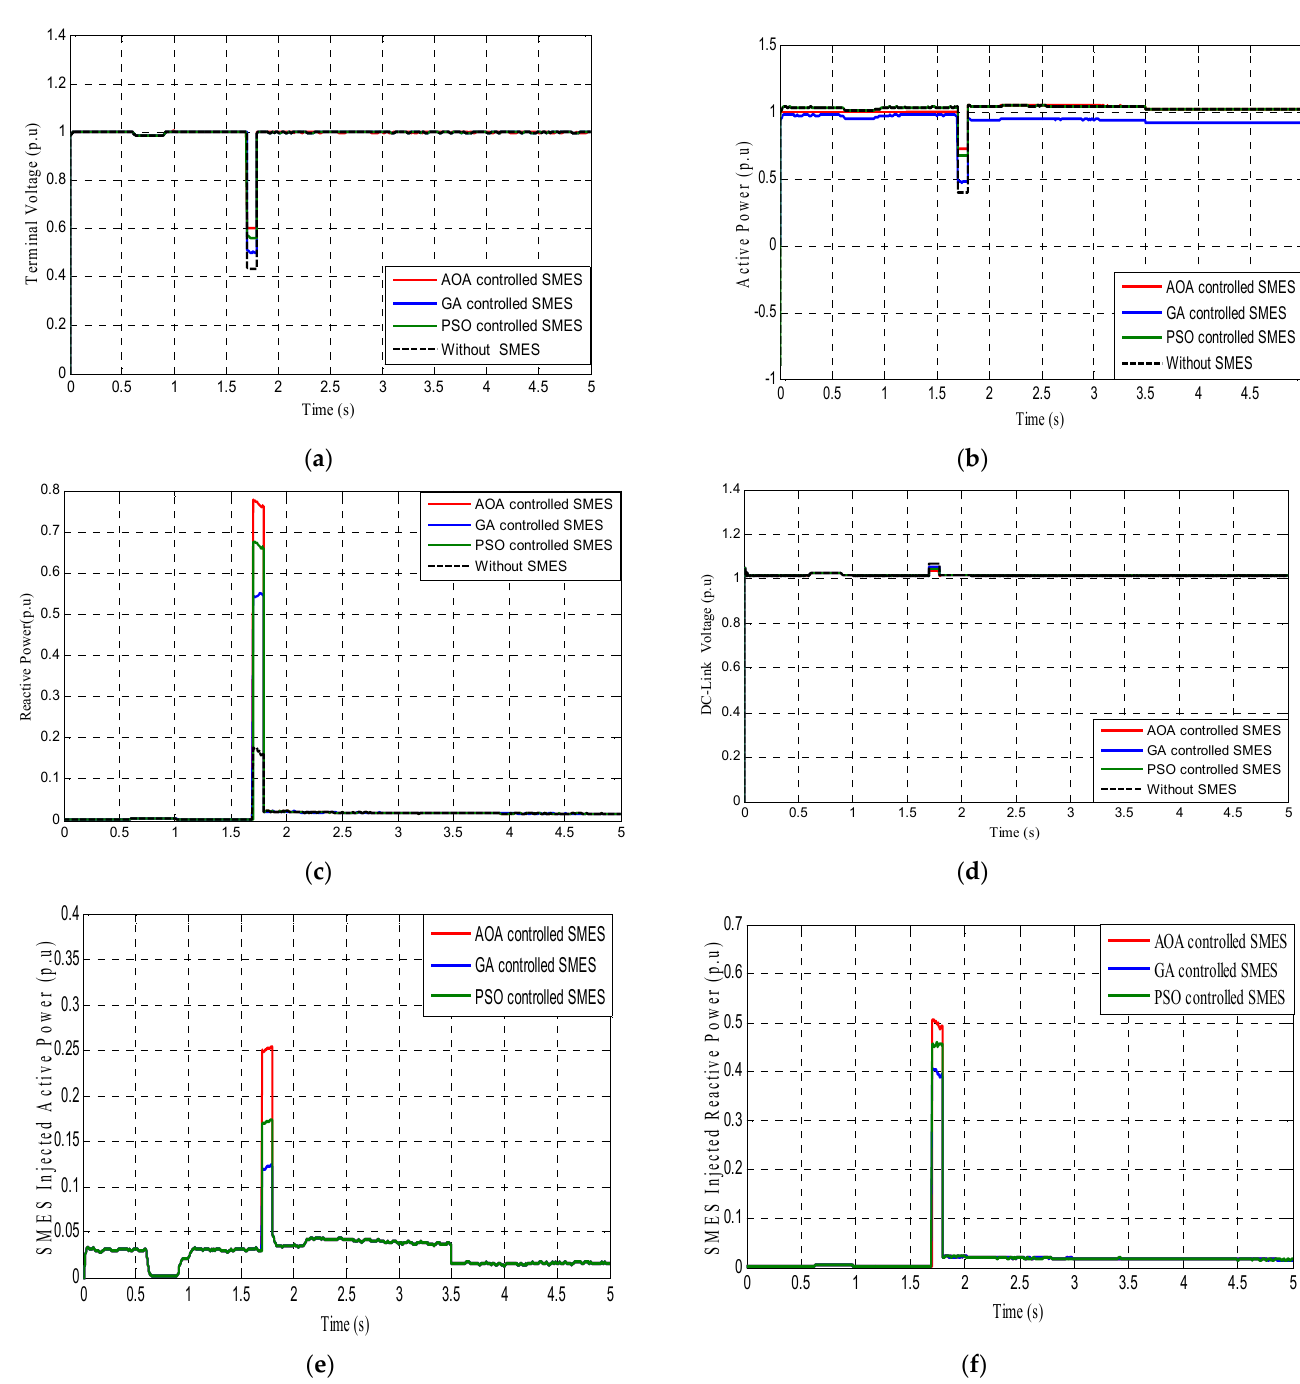
Table 11. SMES ‐ injected active and reactive power for L ‐ L scenario.